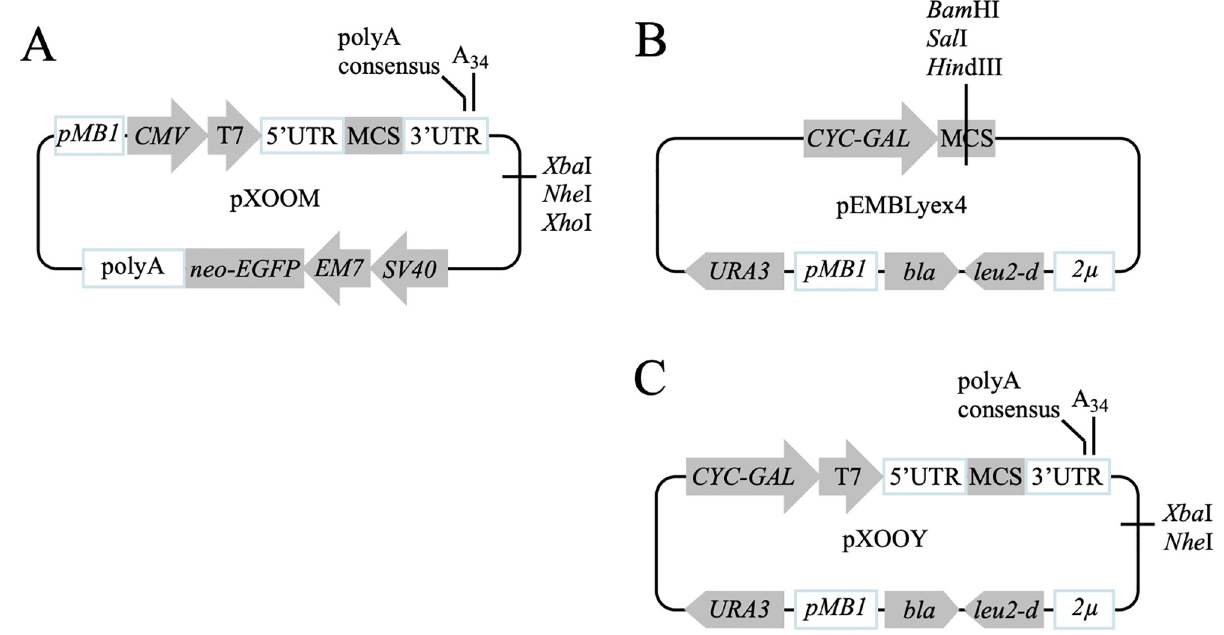
Fig 1. Plasmids used for creation of pXOOY. (A) The dual-function pXOOM plasmid created for heterologous protein expression in both mammalian cells and Xenopus laevis oocytes. CMV , cytomegalovirus early enhancer and promoter; T7, T7 RNA polymerase promoter; UTRs, both 5’ and 3’ regions from the Xenopus laevis β -globin gene; polyA consensus, native polyadenylation consensus sequence within the 3’UTR of Xenopus laevis β -globin gene; A 34 , synthetic polydT tail for in vitro transcription into a polyA tail; SV40 , simian virus 40 early enhancer and promoter enabling expression of neo/kana-EGFP fusion gene; EM7 , synthetic bacterial promoter directing expression of neo/kana-EGFP fusion gene; neo/kana-EGFP , neomycin resistance-enhanced GFP fusion gene; polyA, simian virus 40 fragment containing a polyadenylation signal. The Xba I, Nhe I and Xho I restriction sites can be used to linearize the plasmid prior to in vitro transcription. (B) pEMBLyex4 provides the backbone for the new pXOOY vector. URA3 , encodes orotidine-5-phosphate decarboxylase; CYC-GAL , a fusion between the CYC1 promoter and the GAL10 upstream activating sequence containing two Gal4 binding sites; MCS, multicloning site; 2μ , yeast two micron origin of replication; leu2-d , poorly expressed allele of the β - isopropylmalate dehydrogenase gene; bla , β -lactamase gene; pMB1 , E . coli origin of replication. The restriction sites for Bam HI, Hin dIII and Sal I are used to linearize the plasmid at the MCS for insertion of PCR fragments into the vector using homologous recombination. (C) Plasmid map of the new dual-function pXOOY vector for expression of proteins in yeast and in Xenopus laevis oocytes. The expression cassette contains elements from pEMBLyex4 required for protein expression in yeast such as the CYC-GAL promoter and a yeast 5’UTR as well as the selective markers URA3 and leu2-d and the 2μ origin of replication. To enable in vitro transcription, it contains the pXOOM T7 promoter and the 3’UTR from the Xenopus laevis β - globin gene, which encodes a synthetic polyA tail comprised of 34 A-nucleotides.